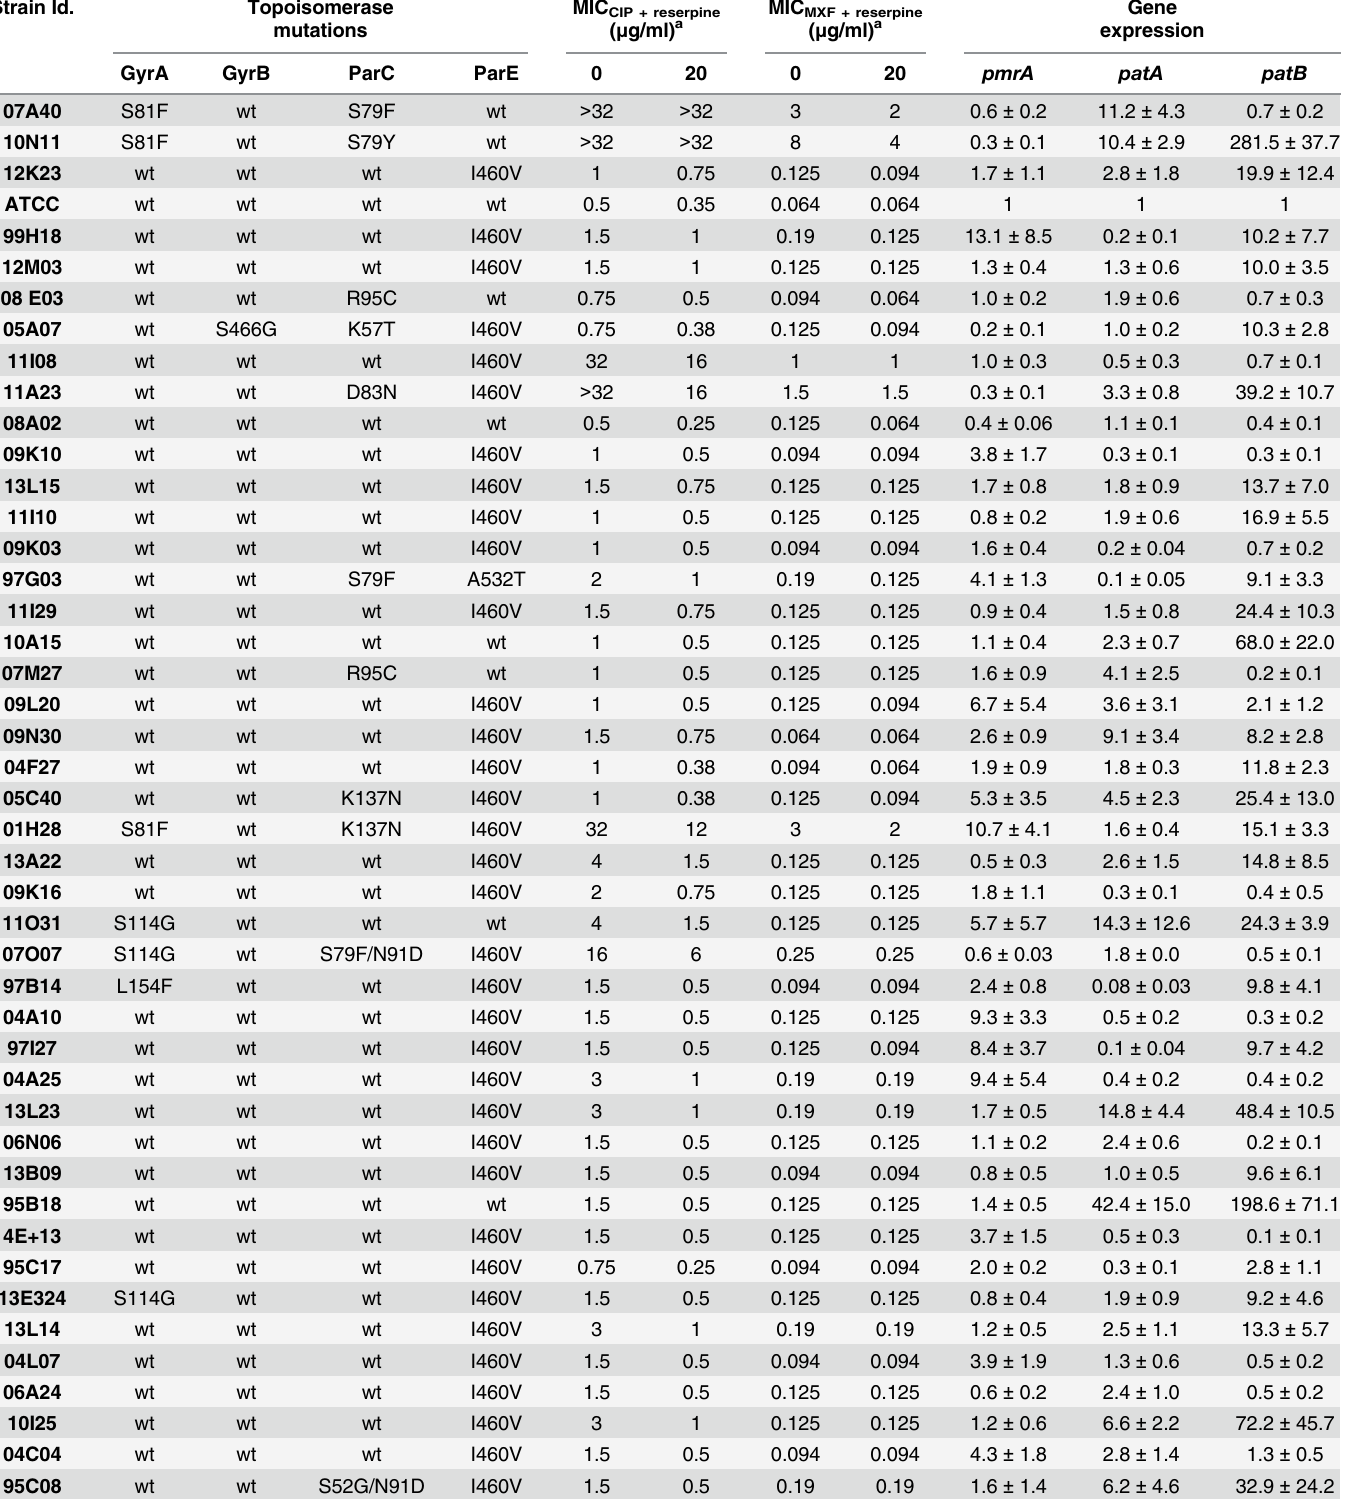
Table 3. Expression analyses of a selection of S . pneumoniae strains, with inclusion of the QRDR sequences and phenotypic FQ-R analyses. Strain